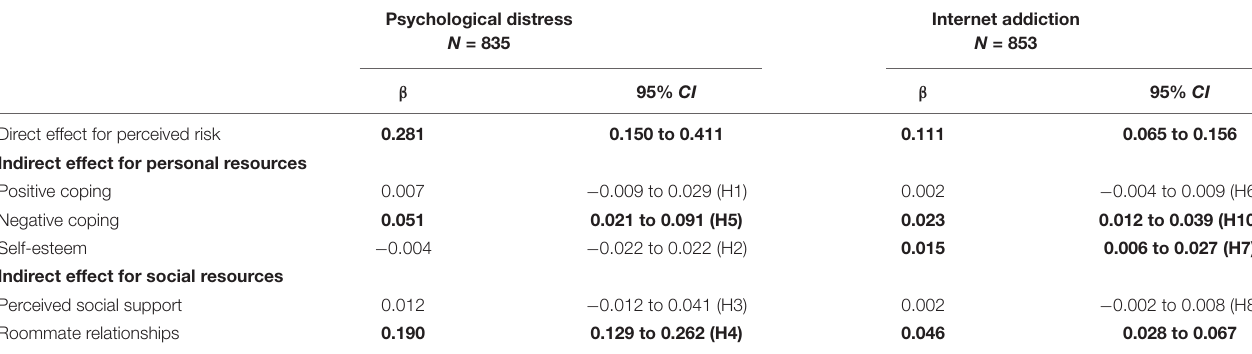
TABLE 2 | The mediating effects of personal and social